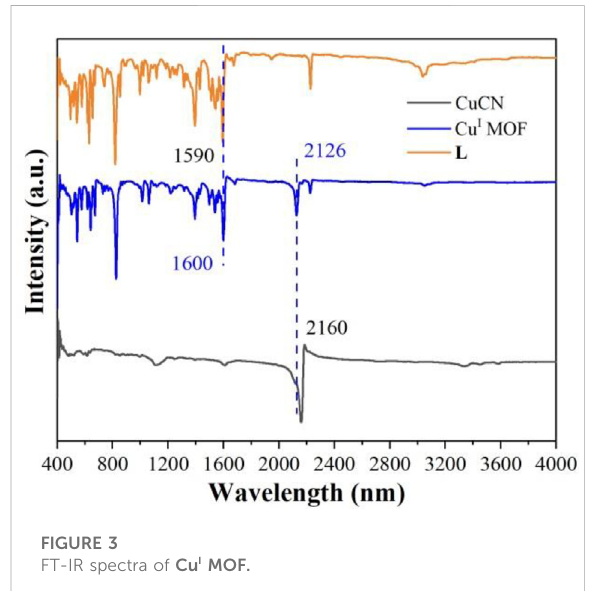
FIGURE 3 FT-IR spectra of Cu I